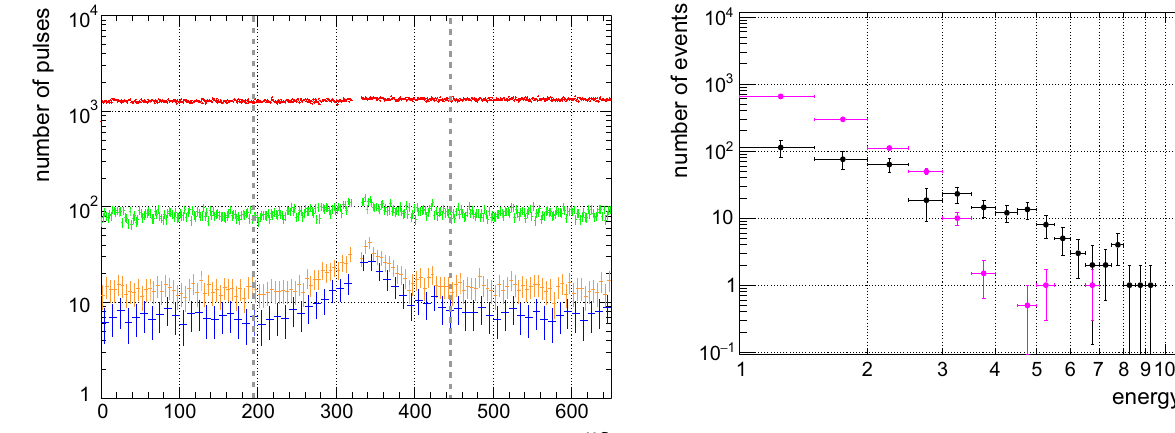
Fig. 7 Energy spectrum of the recoil candidates after background sub- traction (black dots), and background spectrum (magenta